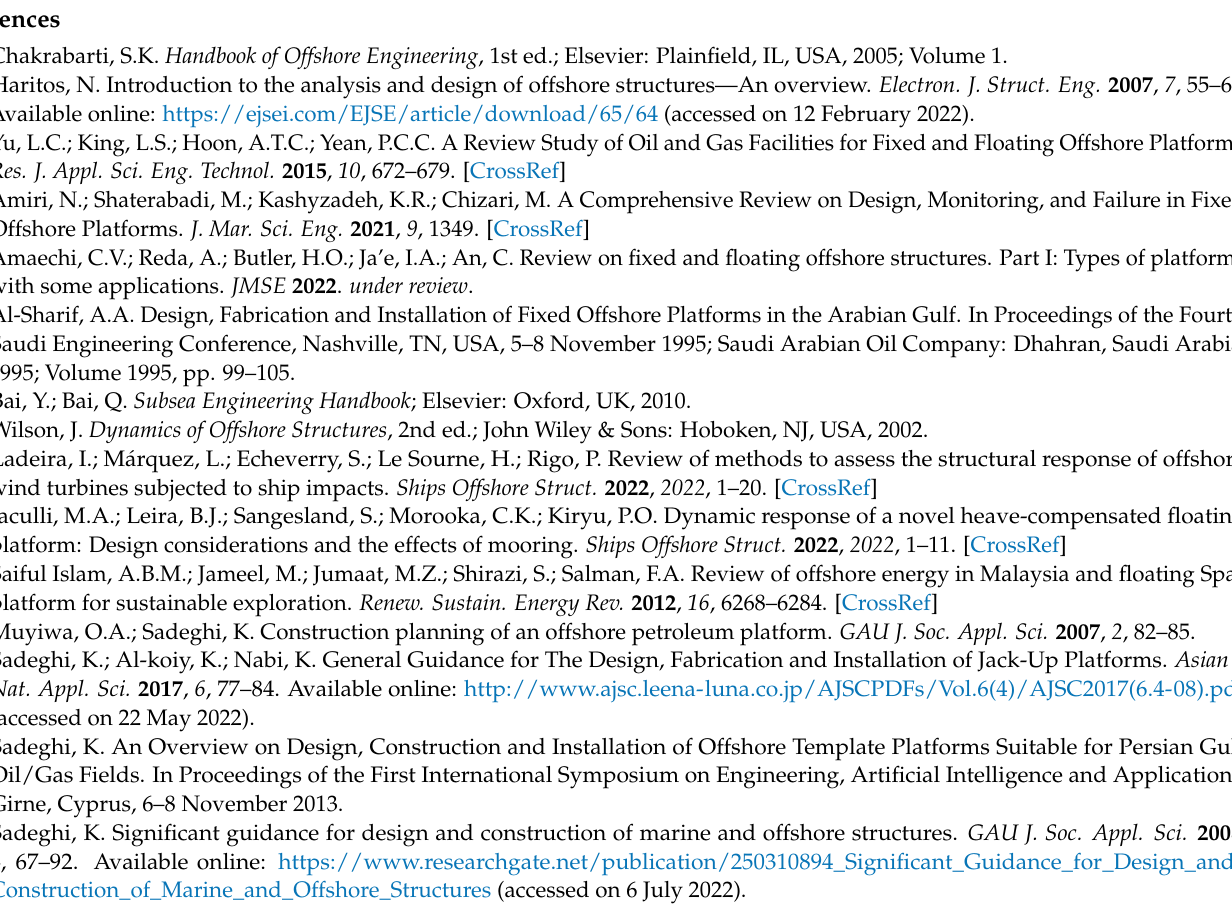
Figure A5. Map of global distribution of wave energy density showing annual mean power density Large Wave Power Density regions exist around 50 ◦ N and 50 ◦ S (red represents highest wave power density and arrows represent predominant direction). (Permission obtained to reuse image from Elsevier. Author: Kester Gunn and Clym Stock-Williams; Publication: Renewable Energy; Publisher: Elsevier; Date: August 2012; Source